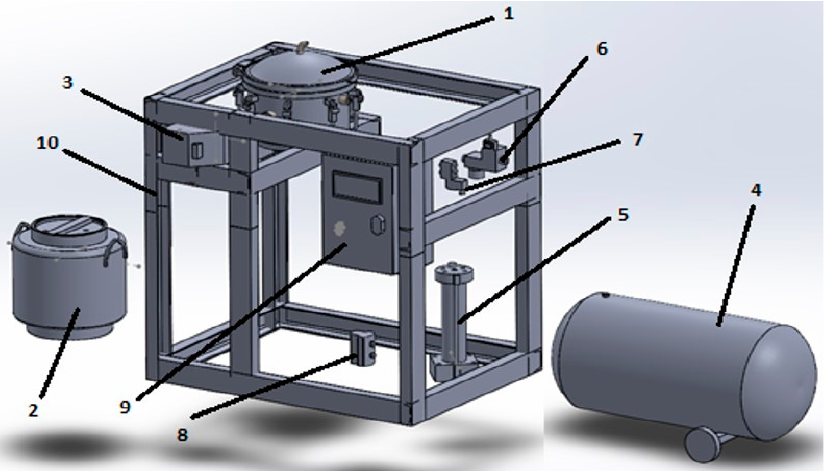
Figure 3. Simplified schematic and experimental model for the bioactive-compounds extraction equipment: 1, extraction vessel; 2, expansion and solvent storage tank; 3, ultrasonication system; 4, pressure generator; 5, hydro-pneumatic cylinder; 6, pressure regulator; 7, liquid filtration system; 8, liquid recirculation pump; 9, process monitoring and control system; 10, support